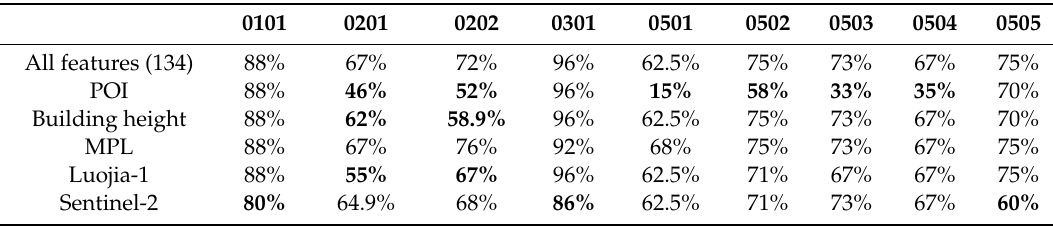
Table 7. Changes of the OA in Level II categories in EULUC-Nanjing after removing features of a certain type. (The values with large changes are shown in